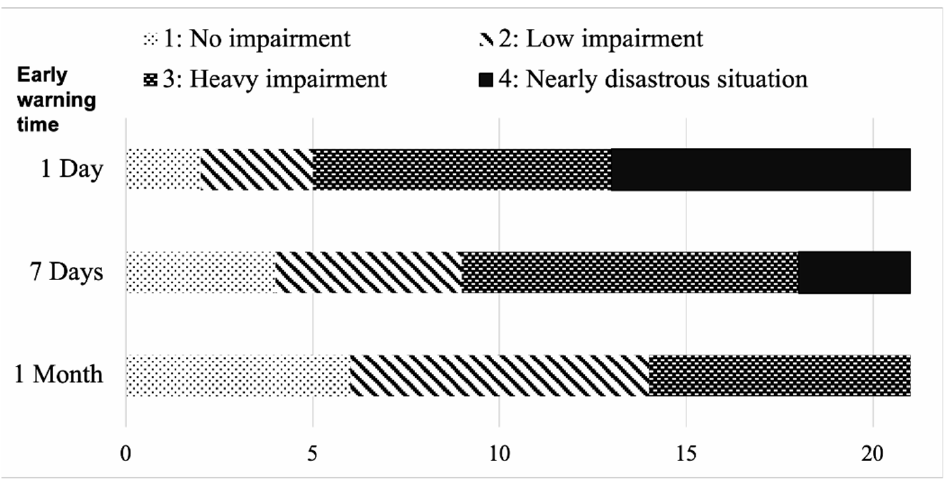
Figure 16. Criticality depending on early warning time—closure of three weeks.